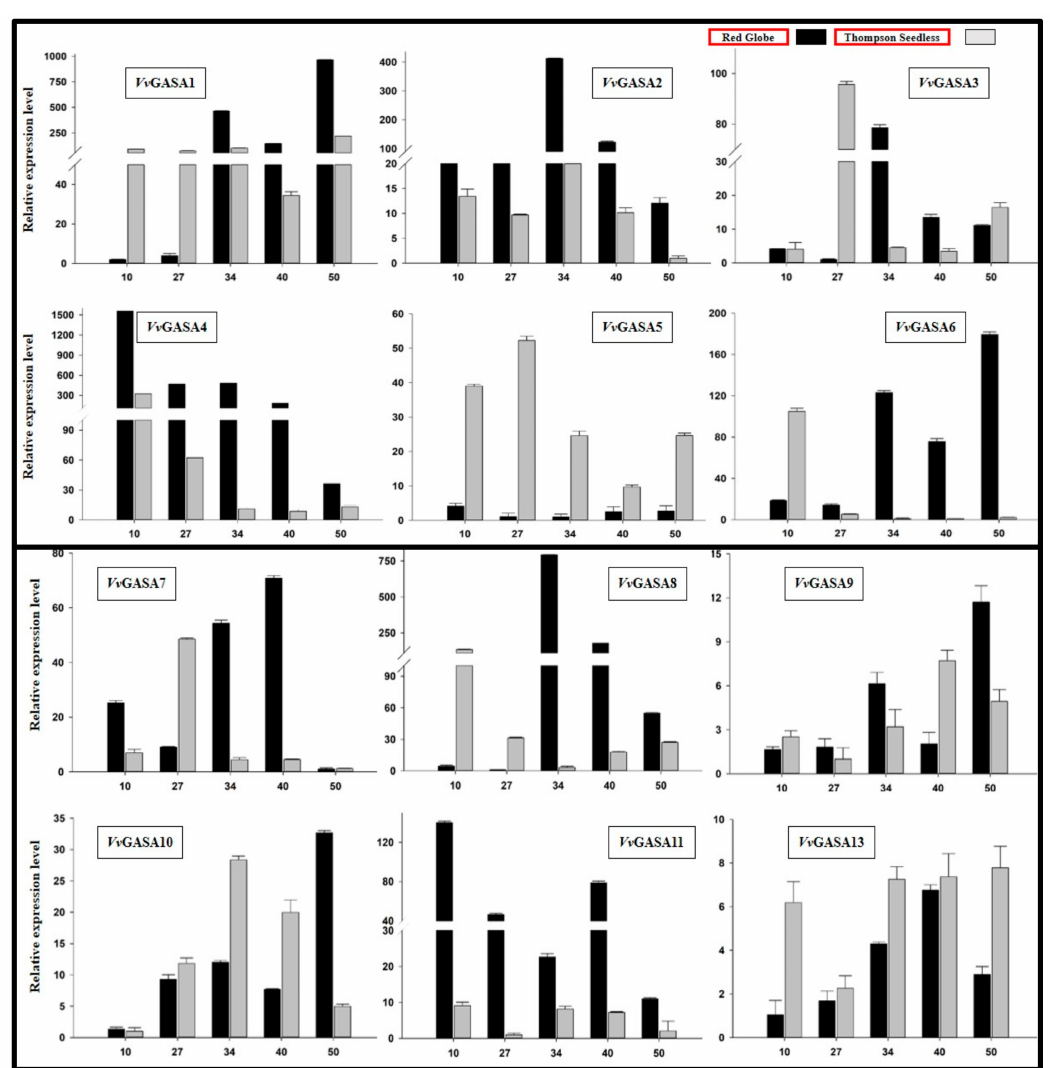
Figure 5. Real-time PCR analysis of grapevine GASA genes at di ff erent stages of seed development in seedless and seeded cultivar. Numbers on x -axis denote number of days after full bloom